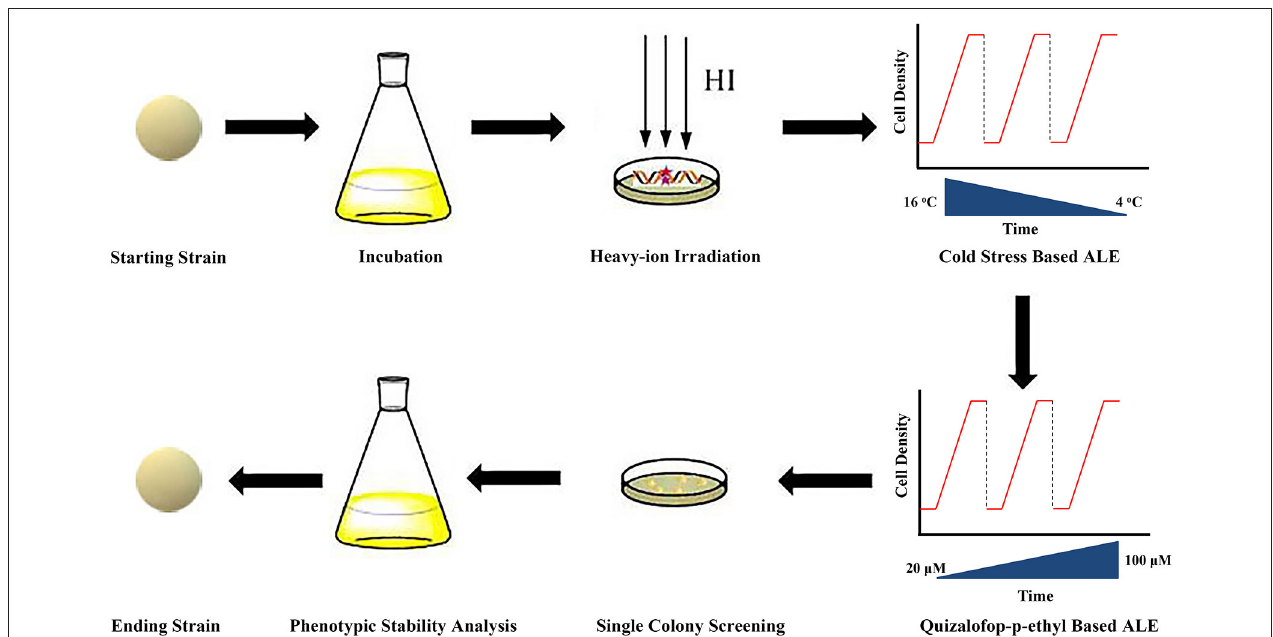
FIGURE 1 | Overview of the modified ALE strategy. HI, heavy-ion irradiation; CS, cold stress; QE, quizalofop-p-ethyl.